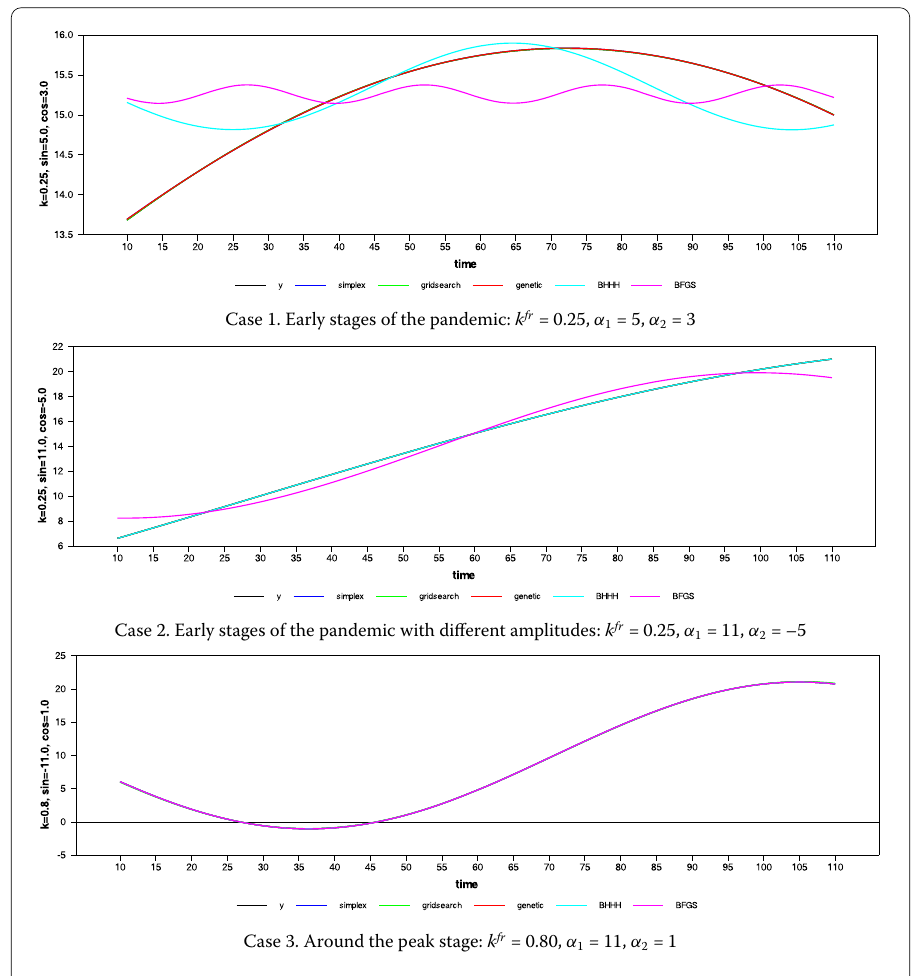
Figure 3 Different DGS and algorithms for obtaining fractional